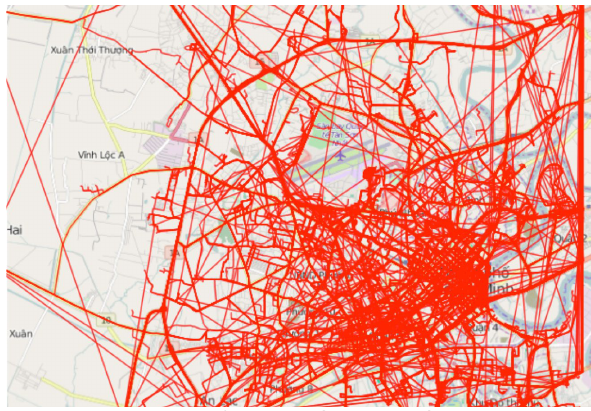
Fig.5. Raw data of the Ho Chi Minh City dataset is very noisy.